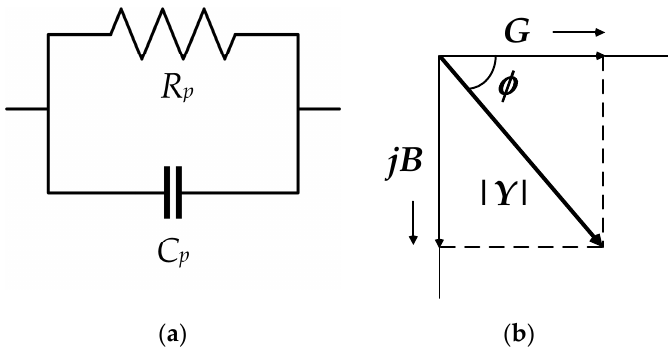
Figure 2. Equivalent circuit model of soil and graphical representation of admittance: ( a ) RC parallel circuit model; ( b ) admittance in the complex